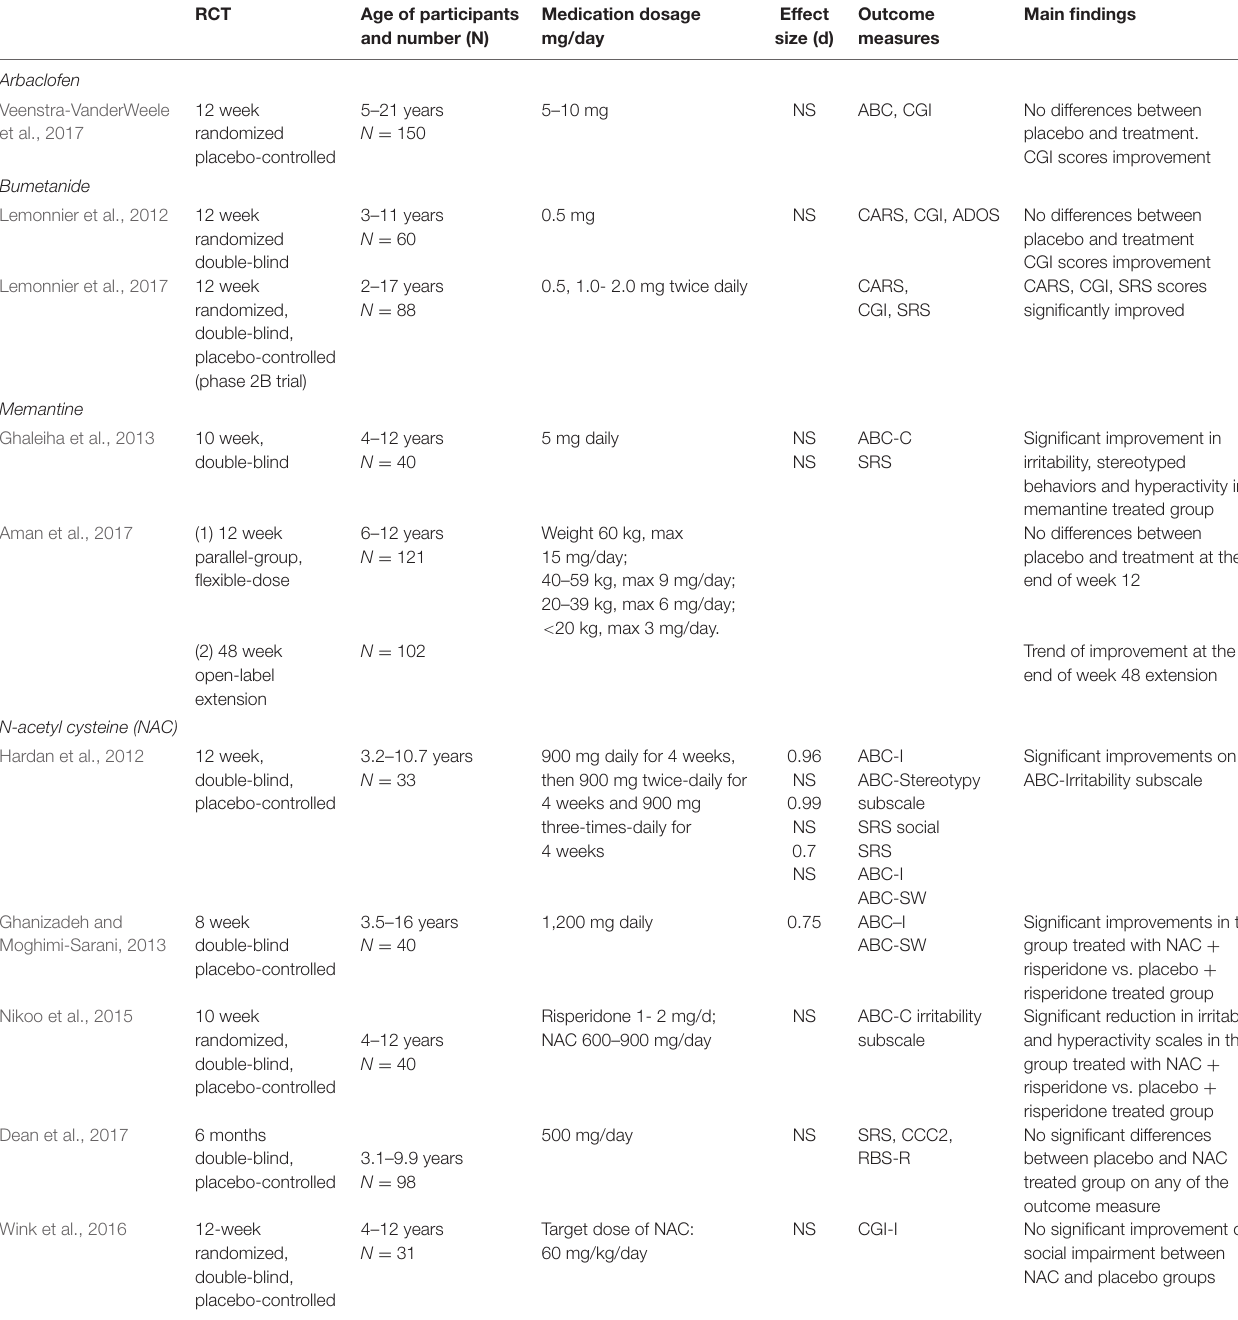
TABLE 1 | Randomized control trials (RCT) with excitatory/inhibitory (E/I) modulators in ASD. RCT Age of participants and number